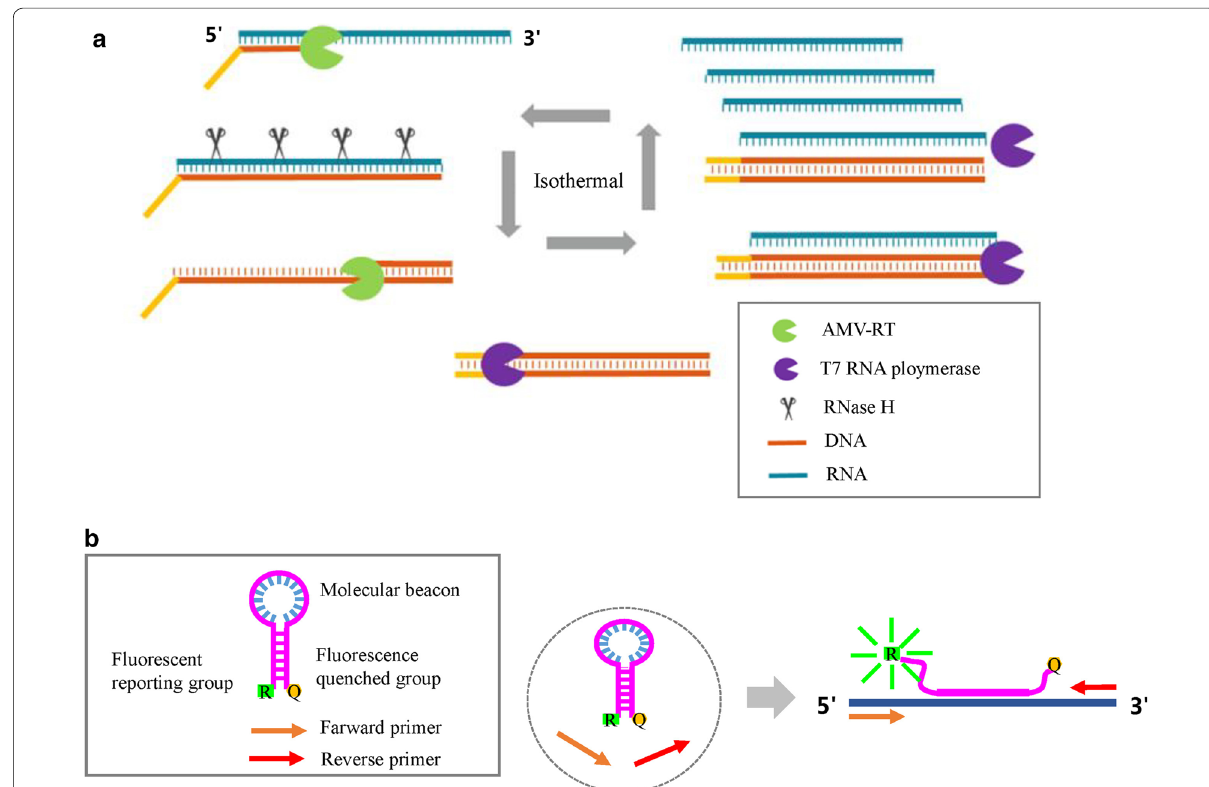
Fig. 2 Principles of the MNCP based on NASBA amplification. a The isothermal cycle of the NASBA amplification. b Signal reporting of the amplification product. AMV-RT: avian myeloblastosis virus reverse transcriptase; MNCP: micro/nanofluidic chip platform; NASBA: nucleic acid sequence-based